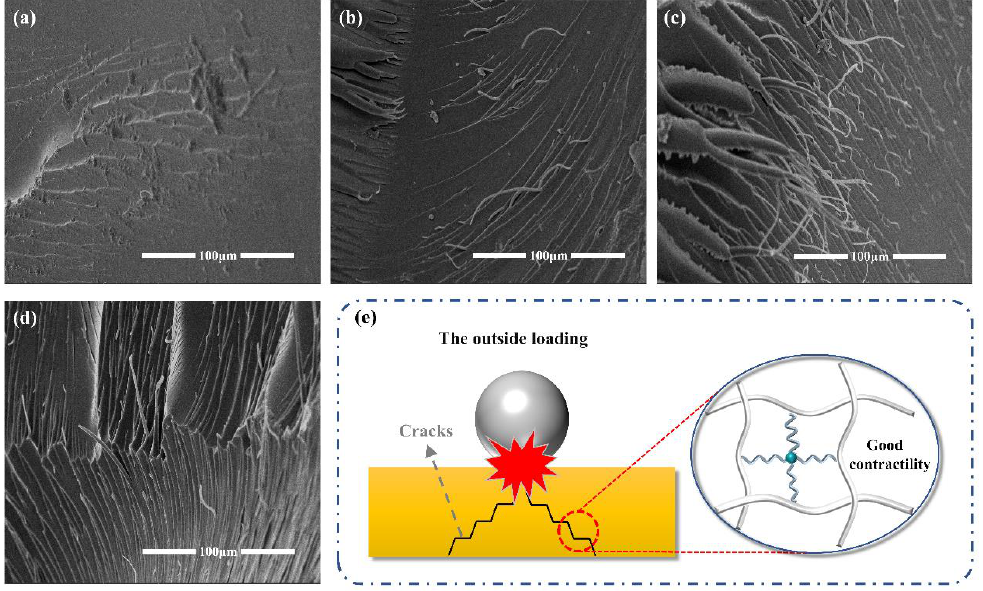
Figure 4. The SEM images of impact fracture surface of ( a ) DGEBA, ( b ) QSiE-2, ( c ) QSiE-4, ( d ) QSiE-6. ( e ) A possible toughening mechanism of QSiE.